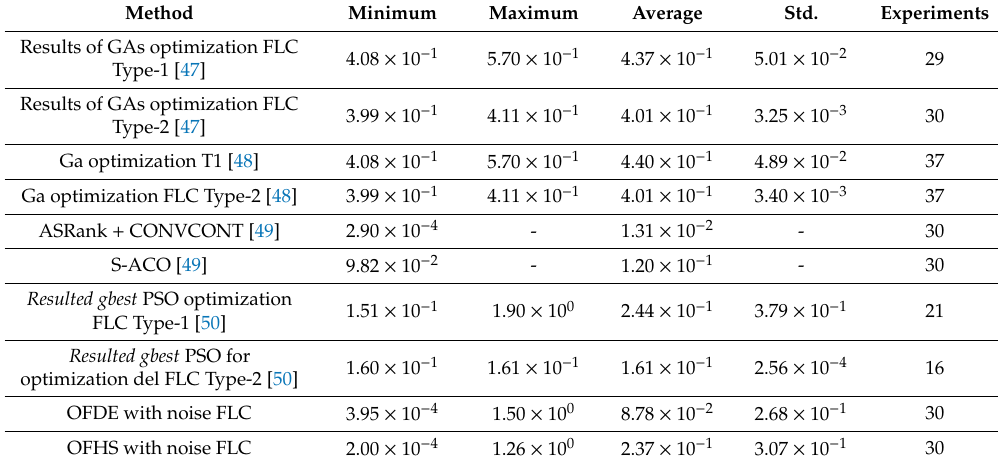
Table 17. Comparison of results with other metaheuristics.